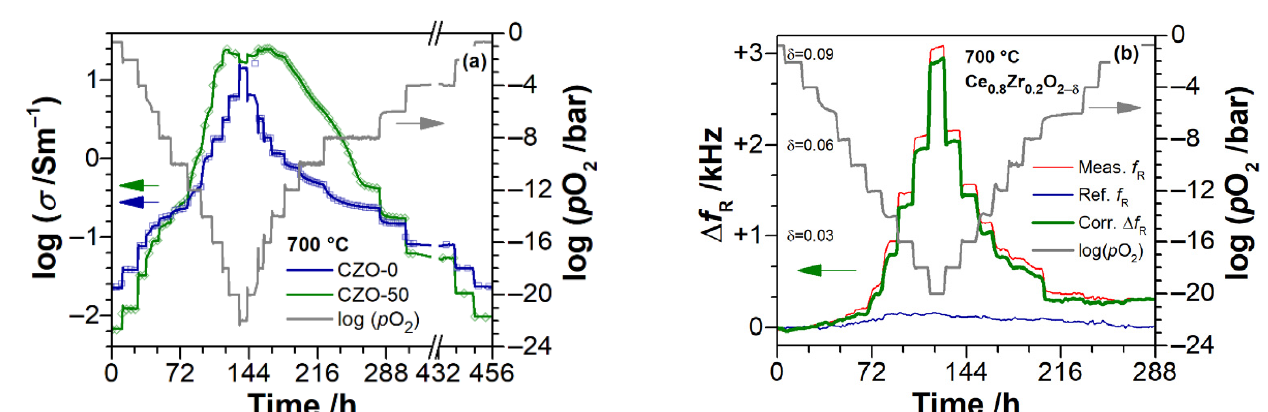
Figure 5. Example for a measurement of the electrical conductivity of CeO 2 and Ce 0.5 Zr 0.5 O 2 thin films ( a ) and the change of the resonant frequency ∆ f R for CZO-20 coated CTGS resonator ( b ) upon stepwise changes of p O 2 at 700 ◦ C. In ( a ) open symbols represent the EIS measurements and solid lines the DC measurements. In ( b ) , the raw measurement data (Meas. f R ) are corrected for f R of a reference resonator (Ref. f R ), yielding the signal of interest ∆ f R (Corr. ∆ f R , which is primarily compensated for temperature fluctuations). The frequency shift is given with respect to Meas. f R at p O 2 = 0.2 bar. The corresponding non-stoichiometry values, as evaluated by Equation (10), are pro- vided.